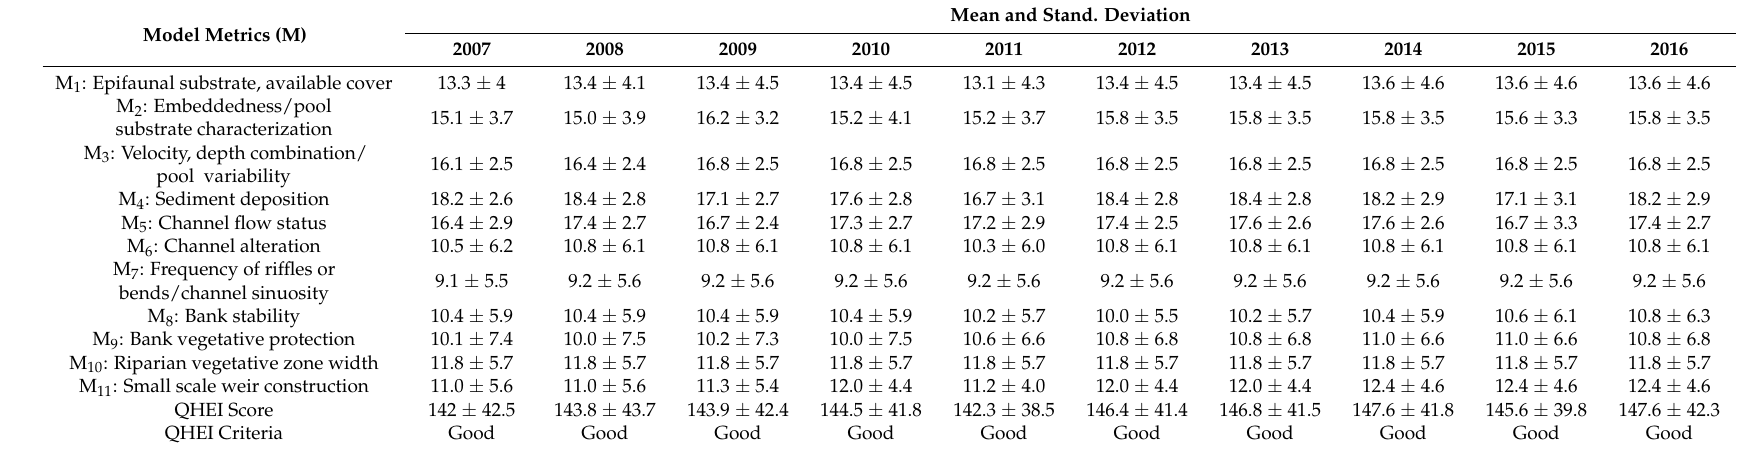
Table 4. Annual results of qualitative habitat evaluation index (QHEI) and habit status evaluation in Gap Stream during 2007–2016. Model Metrics